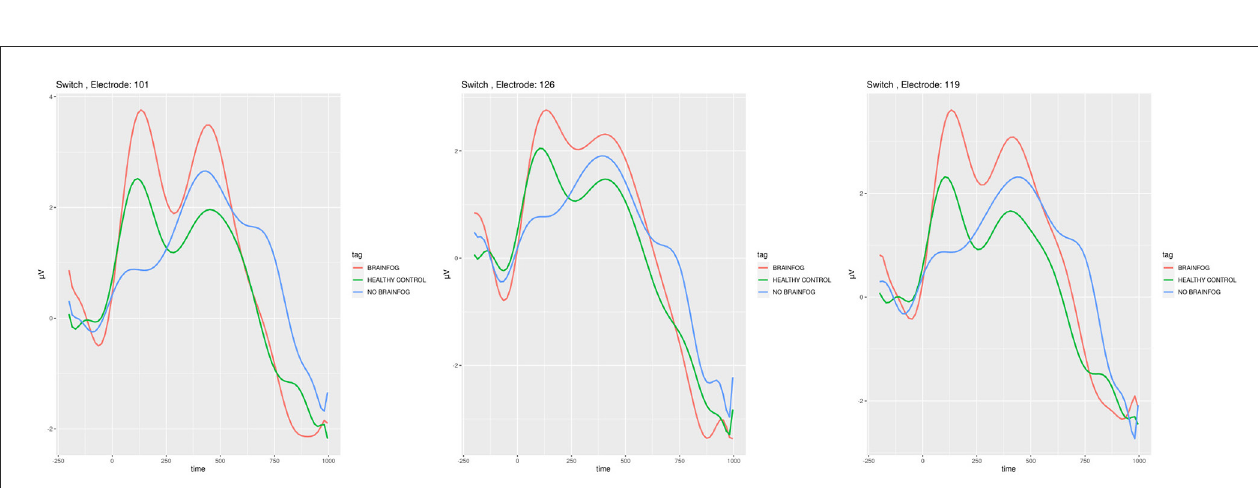
FIGURE8 ERP plots generated for the electrodes E101 , E126 , and E119 that showed the smallest cross-correlation in the task-switching experiment when the participants saw letters . Red line—the participants that suffered from COVID-19 and with brain fog symptoms. Blue line—the participants that suffered from COVID-19 and without brain fog symptoms. Green line—the participants without COVID-19 episode. See also Tables 14–17 in Appendix